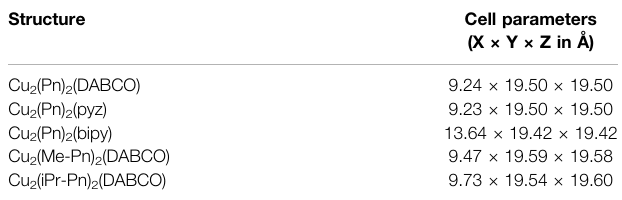
TABLE 1 | Unit cell parameters of PCU-type MOF structures studied.